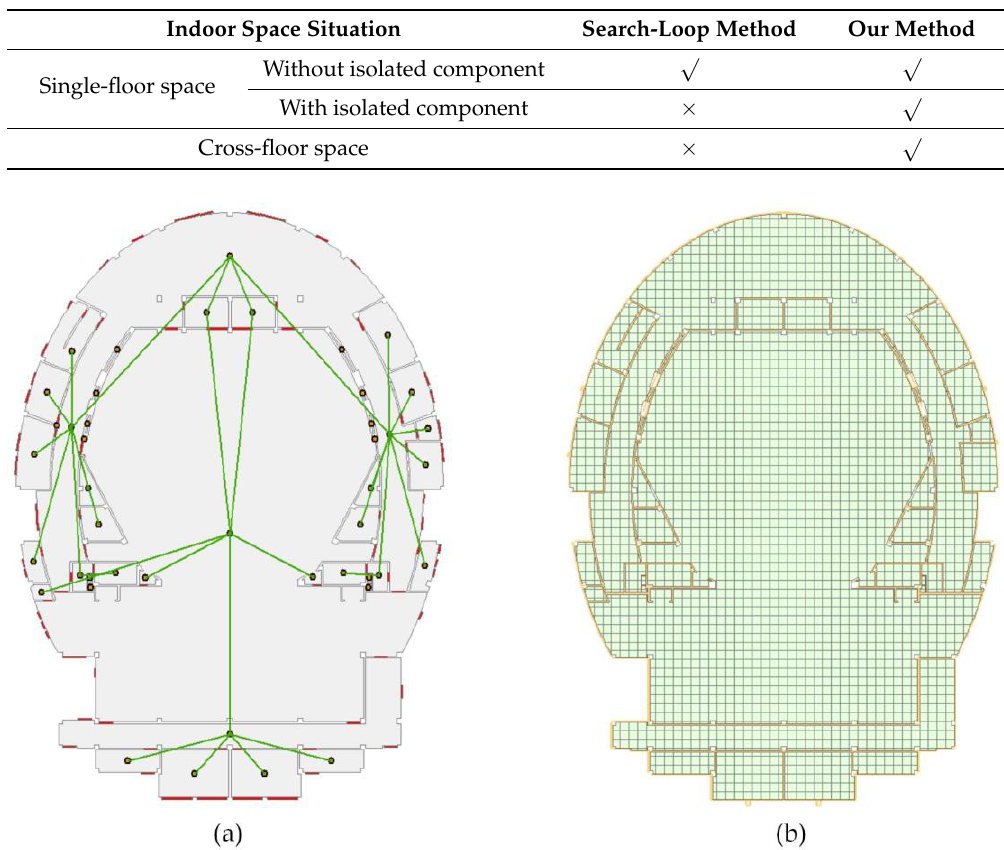
Table 5. Comparison of the extraction methods.